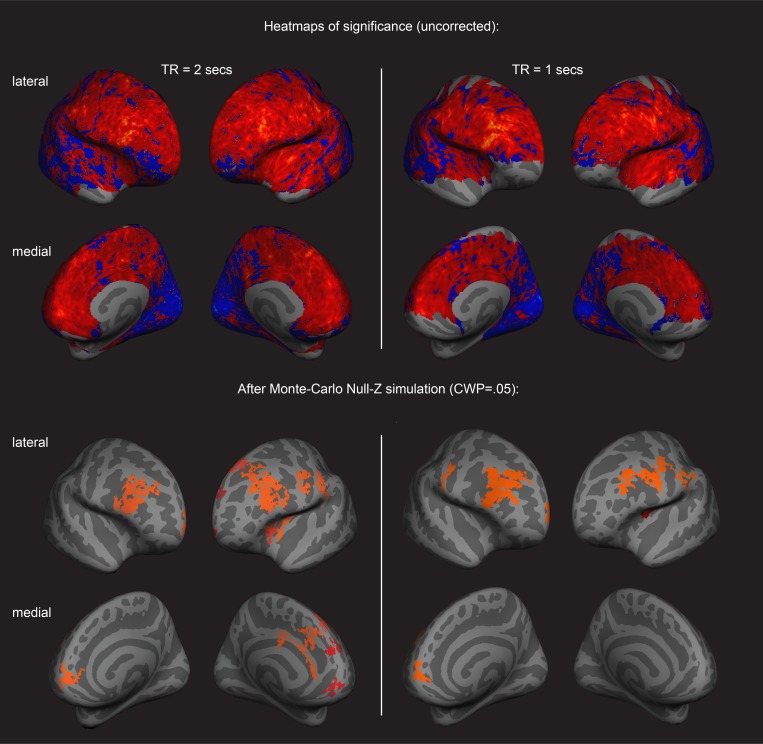
Surface-based brain analysis of data from two different fMRI resting-state measurements and imagery: positive associations with imagery strength in the frontal cortex.Results of the main resting-state fMRI data set with a TR = 2 s are shown on the left (TR2); results of an additional resting-state fMRI data set with a TR = 1 s are shown on the right (TR1); in those participants with which both measurements were conducted, about half were done on the same day. In the other half, the two measurements were conducted on different days. The two upper rows show the uncorrected (positive and negative) relationships with imagery as heatmaps. The two lower rows show the corrected clusters that had a positive association with individual imagery strength at a cluster-wise probability threshold of p<0.05 (also see Supplementary Table S2). In both the lateral and medial views, the hemispheres are shown from the front. Multiple comparison correction was done using Monte Carlo Null-Z simulation (mc-z). No smoothing of the functional data was applied. In line with the correlation analyses using normalised fMRI mean intensity of atlas- and retinotopically defined areas, only fMRI mean intensity clusters in frontal areas showed positive associations with imagery strength (% primed). As elaborated in Figure 2, the signal-to-noise ratio is lower in the fMRI measurement with the TR of 1 s (on the right). In the ROI-based approach, none of the brain-behavior relationships survived multiple comparison correction (all p>0.05). Nevertheless, the clusters in the surface-based group analysis from the two different measurements show strong overlaps, indicating the reliability of the measurements. These similarities were not driven by the group that completed the measurements on the same day (analysis not shown).